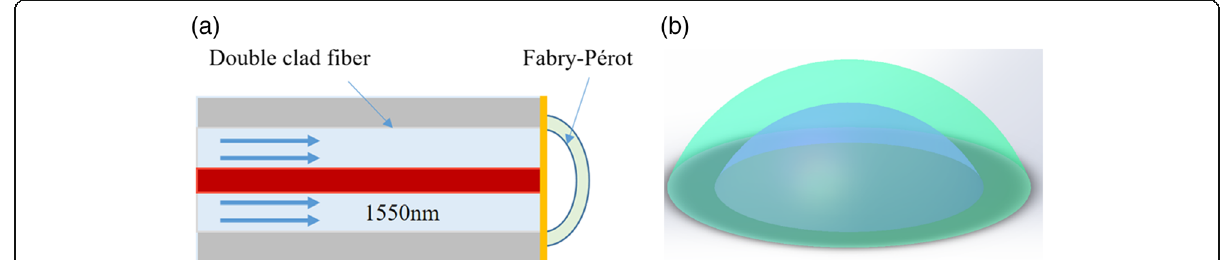
Fig. 1 ( a ) Schematic diagram of ultrasound detection based on the F – P cavity. The red area is the fiber core, the light blue area is the first inner cladding of the fiber, and the yellow area is the gold film formed by gold plating on the end face of the fiber. In addition, the arc part is the structure made of photoresist, and the F – P cavity is formed with the end face of the fiber. ( b ) Pattern layout of the F – P cavity using design software to create a model diagram corresponding to the arc-shaped part of ( a